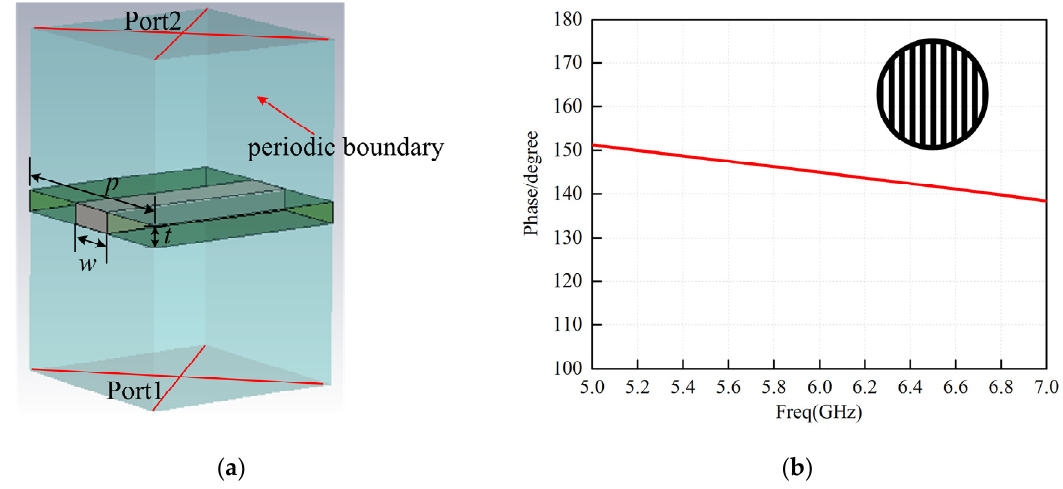
Figure 4. ( a ) Simulation model of the unit cell; ( b ) reflection phase of the planar superstrate.